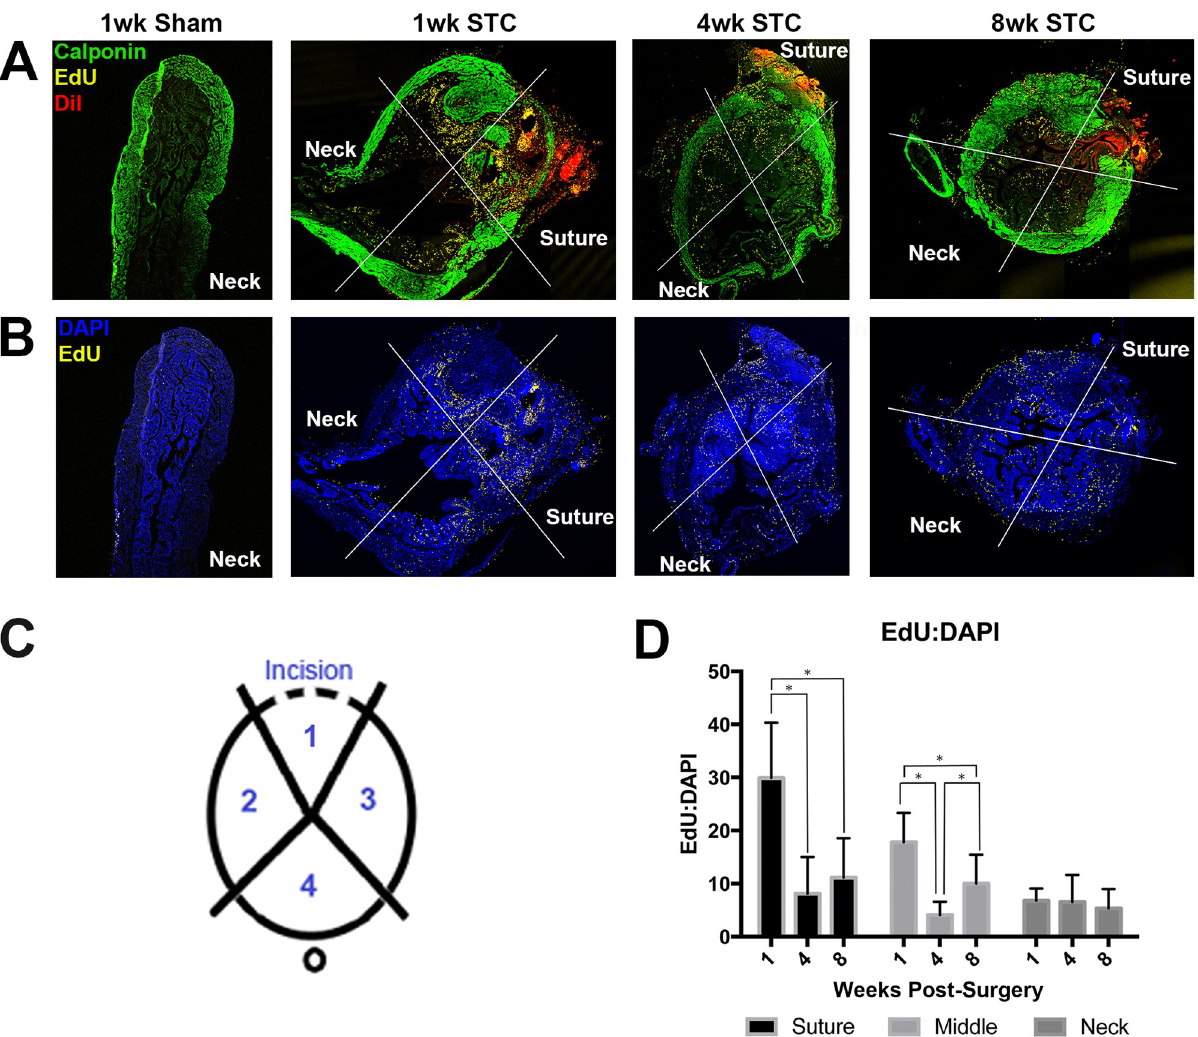
Fig 6. Regenerating cells originate primarily from the suture site. (A) Tiled confocal images of bladder sections stained with anti-calponin (green), EdU (yellow), and DiI (red). Time after STC surgery is indicated above each set of panels. The white lines forming a cross indicate the regions that were analyzed for fluorescent pixels. DiI was applied to the suture immediately after the bladder was sealed. (B) The same images in (A) showing only EdU (yellow) and DAPI (blue) pixels. This view allows us to see the EdU pixels clearly. (C) EdU incorporation in a sham operated bladder at 1wk showing little incorporation of EdU. (D) Quantification of pixels in images such as those shown in (A). The bar graph indicates the ratio of EdU pixels to DAPI pixels in the indicated regions at the indicated times after surgery. Significance is indicated above bars (P < 0.05). Error bars are standard error of the